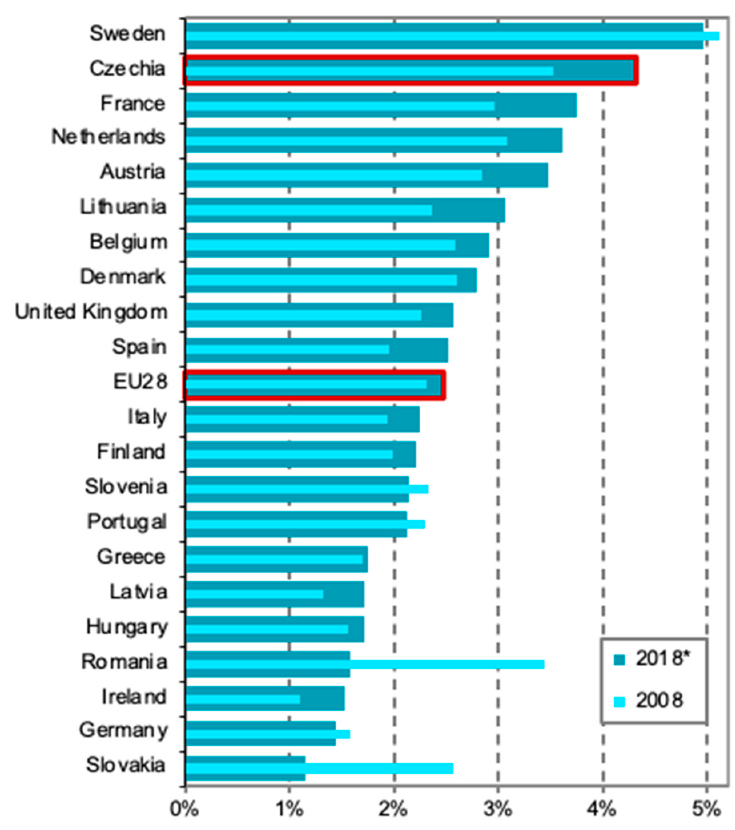
Figure 6. ICT investment (% of GDP, *or the nearest available year).